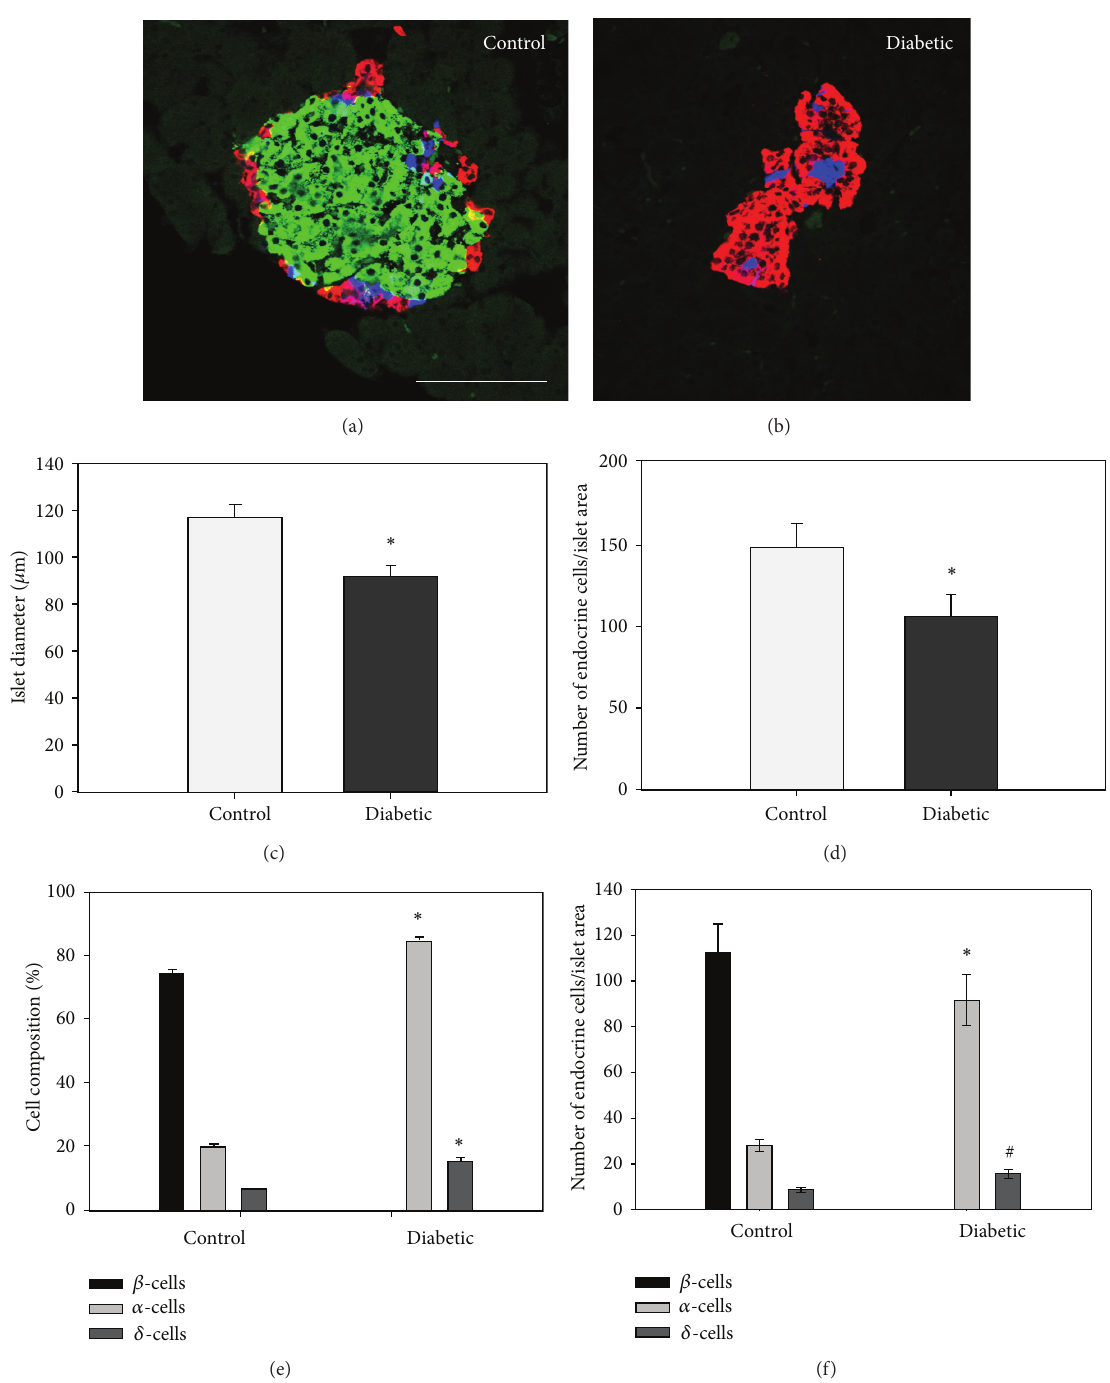
Figure 2: Islet size and composition in BBDR rats. (a) Immunofluorescence staining of an islet from a control animal with a 𝛽 -cell core (anti- insulin; green staining), surrounded by 𝛼 -cells (antiglucagon; red), and 𝛿 -cells (antisomatostatin; blue). Scale bar = 100 𝜇 m. (b) Same staining protocol used on an islet from a diabetic animal (scale the same). (c) Islet diameter decreased in animals with diabetes ( ∗ = 𝑃 < 0.001 ). (d) This decrease was not due to cell atrophy but to a loss in the number of cells ( ∗ = 𝑃 < 0.005 ). (e) The cell composition, as measured by the percentage of endocrine cells, was dramatically different for the 2 groups. Islets of control animals were predominantly 𝛽 -cells, while diabetic animals’ islets were predominantly 𝛼 -cells ( 𝑃 < 0.001 ). (f) The change in cell composition was due to a decrease in the actual number of 𝛽 -cells and a simultaneous increase in the number of 𝛼 -cells and 𝛿 -cells ( ∗ = 𝑃 < 0.001 ; # = 𝑃 < 0.005 ). 𝑁 = 62 islets from 3 control animals and 79 islets from 3 diabetic rats for all